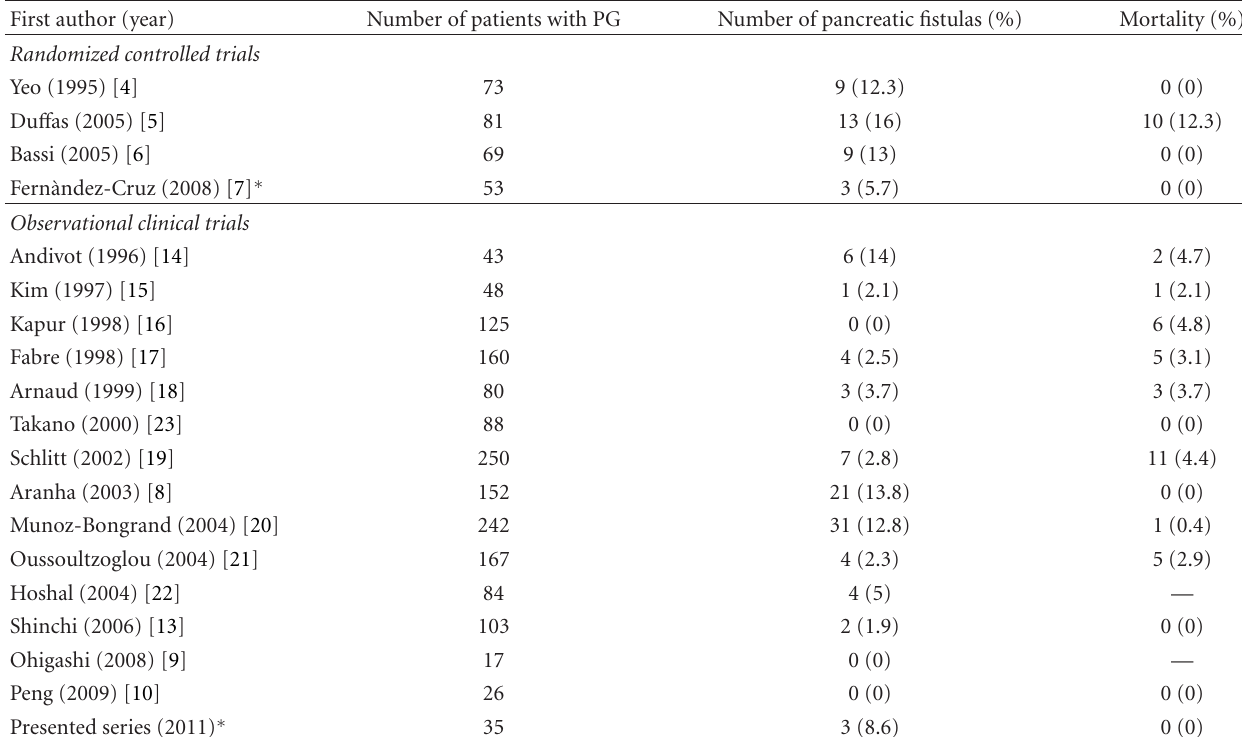
Table 2: Overview on trials on